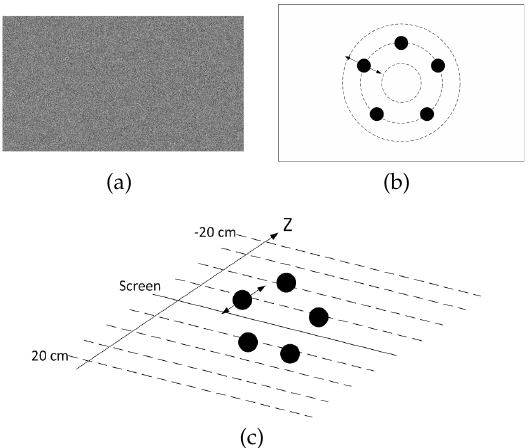
Figure 1 . Composition of the stimuli. (a) The background of the stimuli. Only white-noise is contained in the background, which is positioned behind all the objects at -20 cm. (b) Posi- tions of the objects’ projections on the screen plane. Projected objects laid uniformly on a circle which centers at the screen center. (c) Allocation of objects in depth, potential depth val- ues range from -20 cm to 20 cm by a step of 5